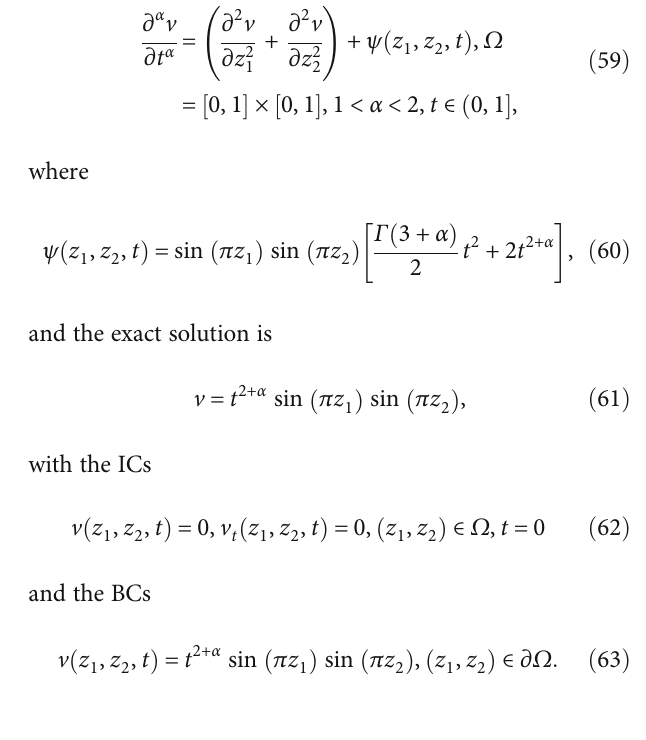
Figure 15: Approximate solution for di ff erent values of α for the Problem exact solution. Figure 7 concerns with the numerical solution at di ff erent time levels. In Table 6, the order of convergence is calculated which shows the convergence of scheme.